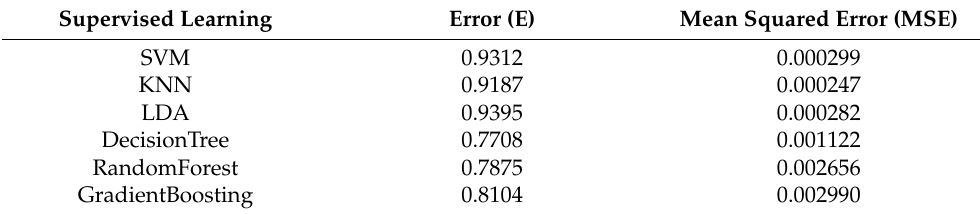
Table 3. The recognition accuracy of cross